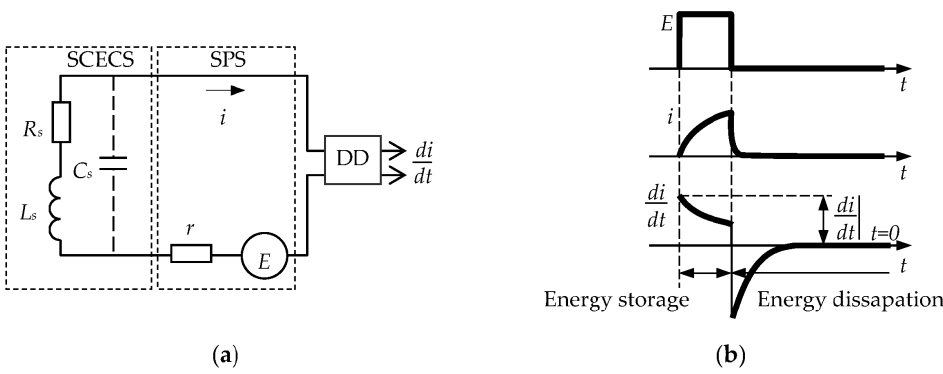
Figure 4. Equivalent scheme ( a ) and time diagrams ( b ) explaining the first derivative method.